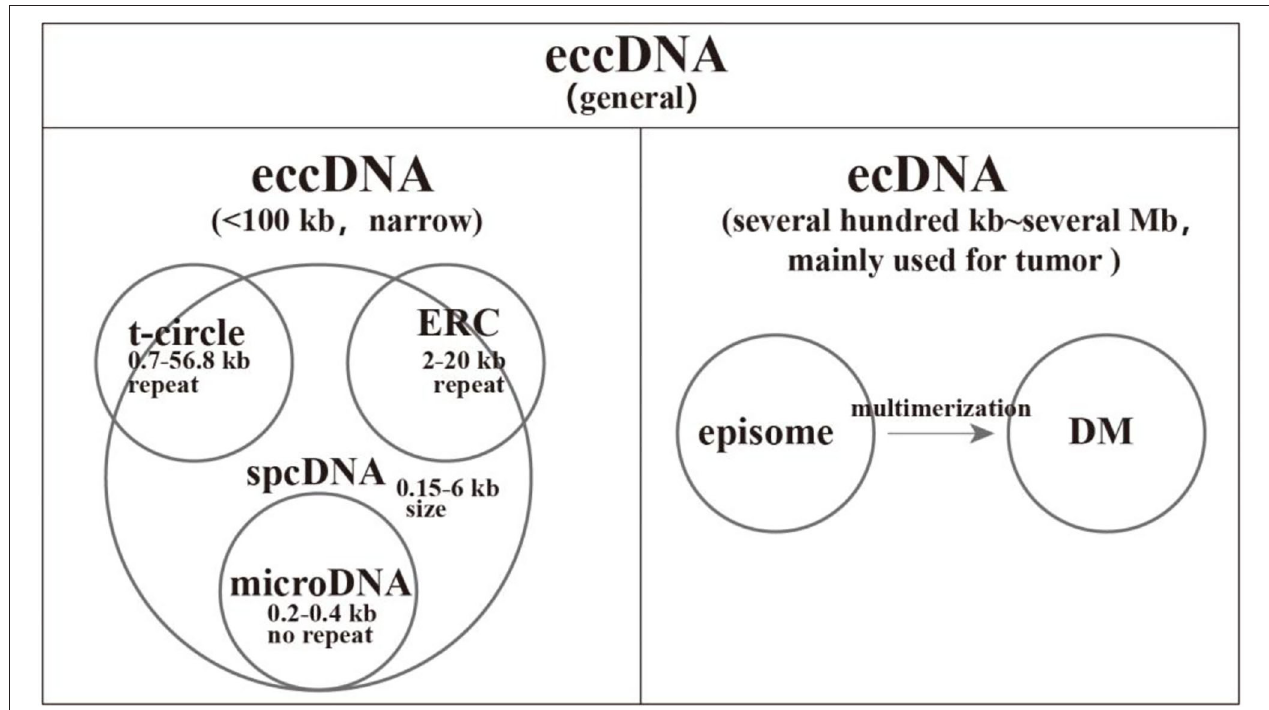
FIGURE 1 | A comprehensive classification of extrachromosomal circular DNAs (eccDNAs). We divide the general eccDNAs into two categories: narrow sense eccDNAs with length < 100kb and ecDNAs common in tumors with size ranging from several 100kb to several megabases. Small polydisperse circular DNA (spcDNA) was an obsolete concept to commonly characterize small eccDNAs with repetitive sequences. The length of extrachromosomal rDNA circles (ERCs) and t-circles is larger than that of spcDNA, which means that some ERCs and t-circles were not covered by spcDNA. The deletion of large genomic fragments could be circularized into episomes and subsequently polymerized into